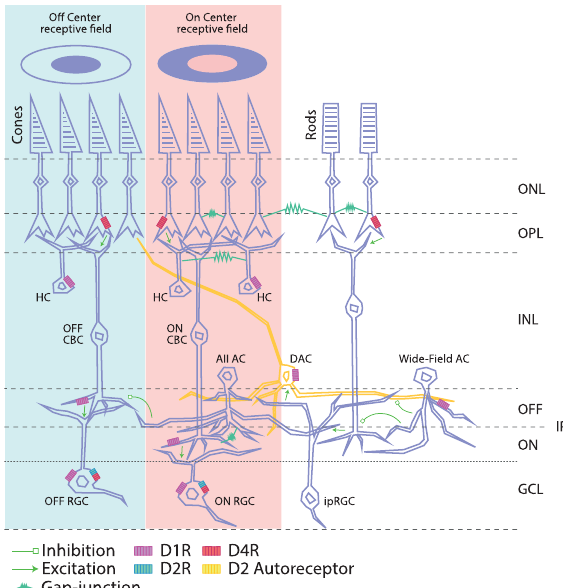
Fig. 3 Distribution of DA receptors in retinal cells. Schematic of the retinal circuitry with cell types expressing speci fi c DA receptors in the retina. The DA receptors D 1 R, D 2 R, and D 4 R and D 2 autoreceptors localized on various cell types are indicated in purple, green, yellow, and red. The dopaminergic amacrine cells (DACs; orange) stratify primarily in the outermost layers of the IPL and send axon-like dendritic projections to cone terminals in the OPL and to the inner layers of the IPL, where they contact AII amacrine cells (ACs). Synaptic excitation and inhibition are illustrated by arrows and bar-line (green). Gap-junctions are shown as sawtooth symbols. The two concentric circles at the top represent OFF-center and ON- center RGCs, which respond oppositely to light in the center and surroundings of their receptive fi elds. DAC: aopaminergic amacrine cell, HC horizontal cell, RBC rod bipolar cell, CBC cone bipolar cell, AC amacrine cell, RGC retinal ganglion cell, ipRGC intrinsically photosensitive RGC. Redrawn from Roy & Fieldl 50